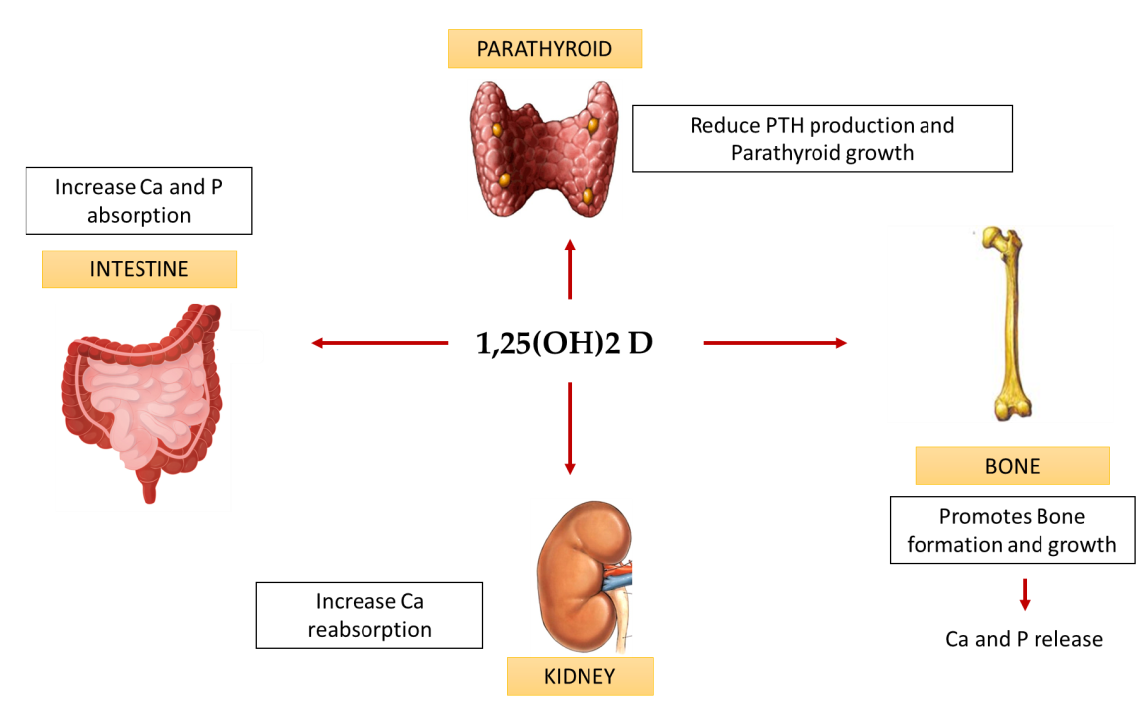
Figure 1. Systemic effect of vitamin D. Ca, calcium; P, phosphorus; PTH, parathyroid hormone.